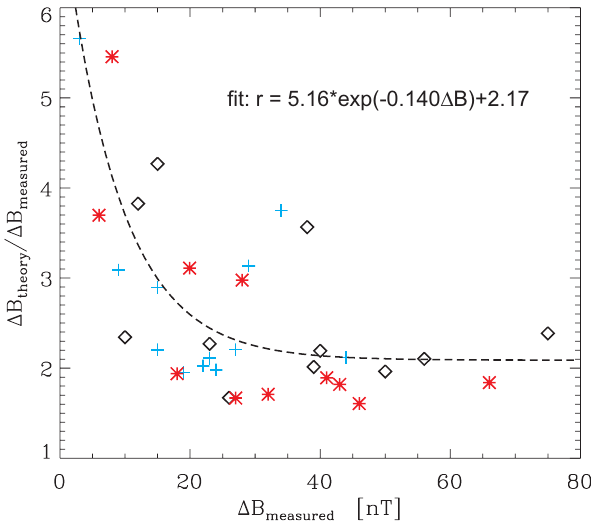
Fig. 9. Plot of the ratio between the expected and observed mag- netic field change as a function of 1 B measured . The expected field change, 1 B theory is calculated from Eq. (6). The different colours correspond to a different orientation of the interplanetary magnetic field. Tentatively an exponential curve of the form r = ae − b1B + c is fitted to the data ( a =5.16, b =0.140, c